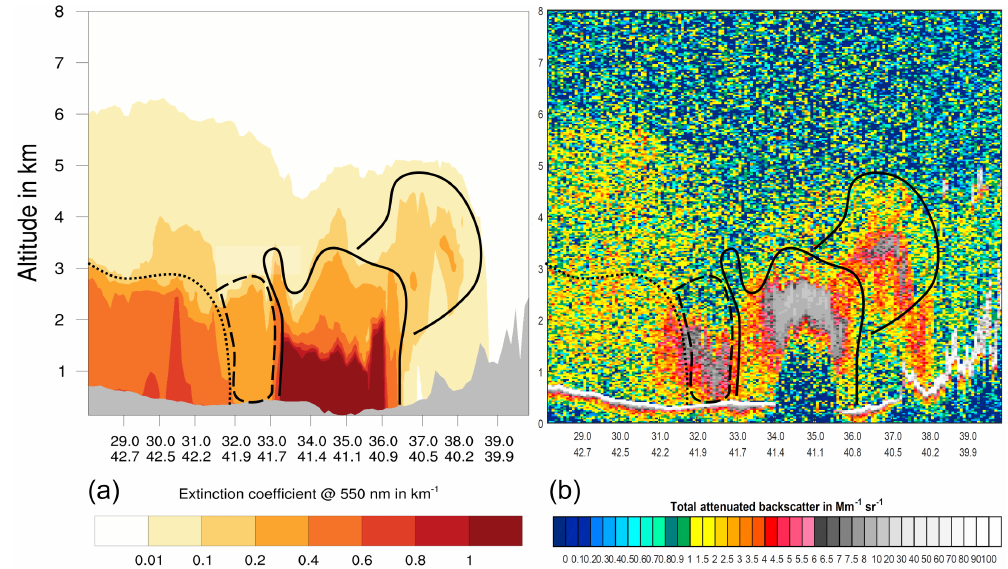
Figure 7. Vertical cross section of ICON-ART model results for 10:00UTC on 7 September and CALIPSO satellite observations from south to north along the ground track in Fig. 6. (a) ICON-ART mineral dust extinction coefficient. (b) Total attenuated backscatter as measured by CALIOP. No quantitative comparison is possible as two different measures are displayed. The southern dotted black line marks the inflow region from the Persian Gulf. The dashed black line marks the inflow region with EM origin. The southern solid black line marks the CPO3. The northern solid black line marks the aged and lifted